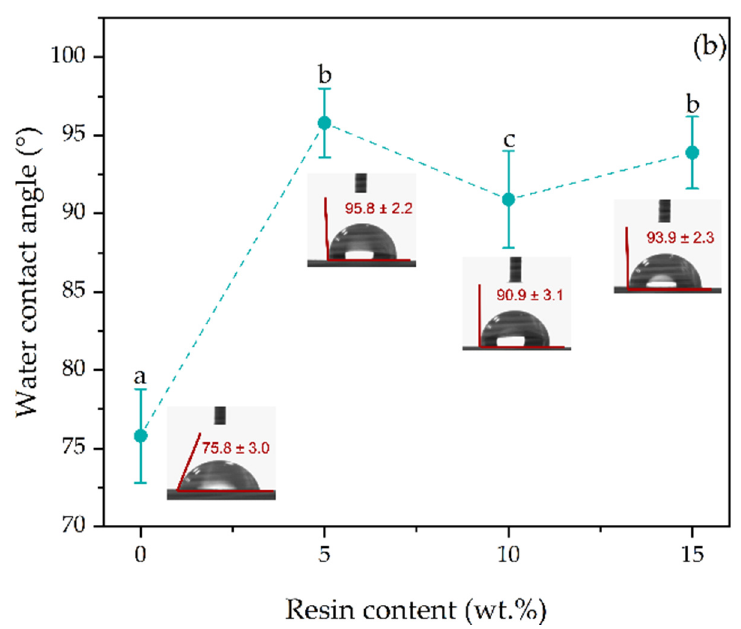
Figure 5. Variation of PBAT water contact angle as function of resin content ( a ) GR and ( b ) UT resin. a–d Different letters show statistically significant differences between formulations ( p < 0.05).